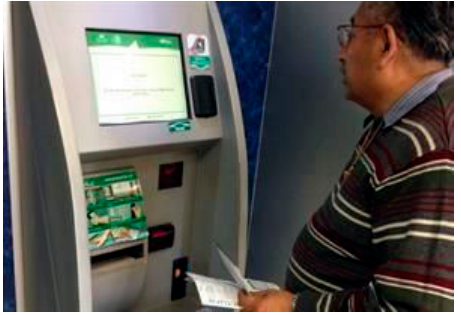
Figure 27. Interface of Mio top-up terminal for public transport in Cali. Instructions manually fixed to hardware with masking tape.